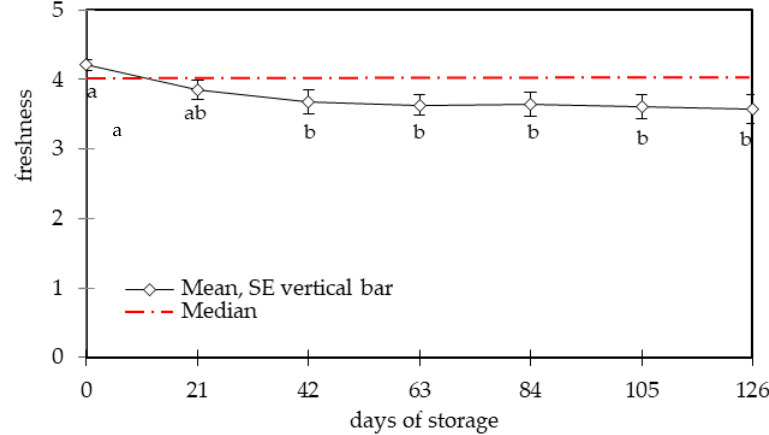
Figure 2. Assessment of the freshness of cured loins stored at 6 °C for 126 days; a,b (continuous line) followed by different letters are significant differences (p < 0.05); bars indicate the standard error for each assessed time. The dashed red line indicates the median values.